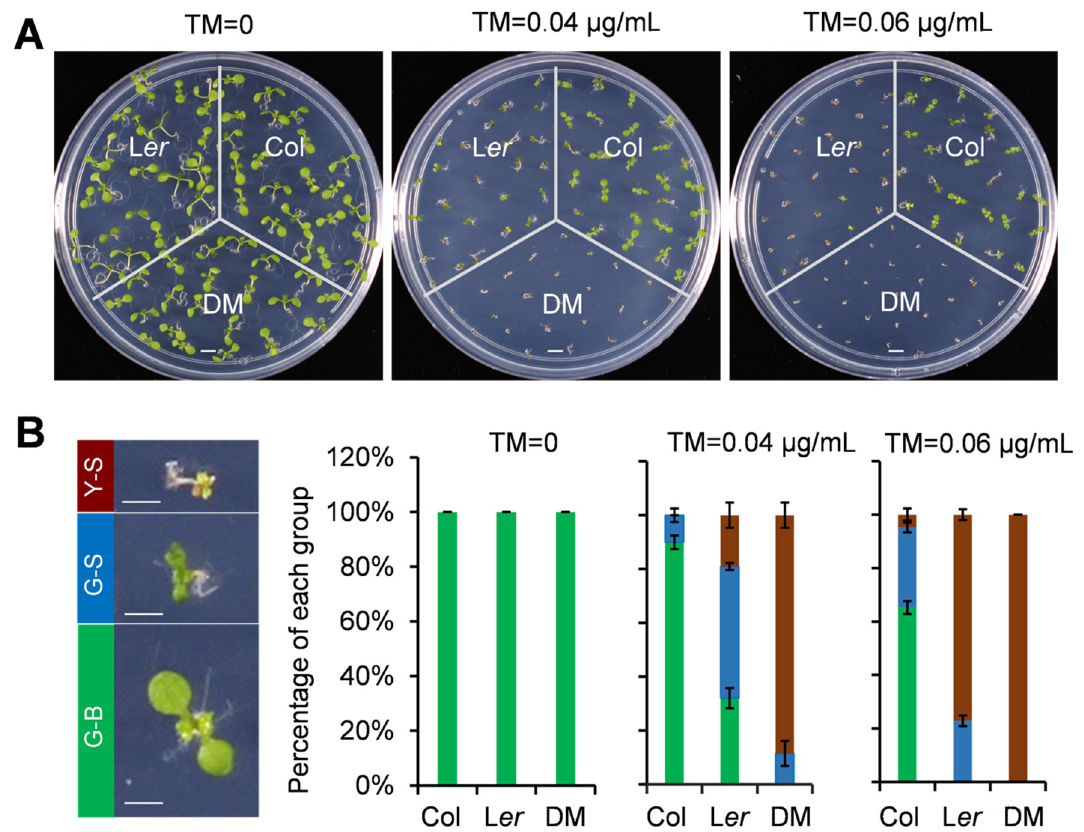
Figure 1. Endoplasmic reticulum (ER) stress sensitivity assays in Columbia (Col), Landsberg erecta (L er ), and double mutant (DM) plants. ( A ) Wild-type Col and L er plants were grown on 1 without or with various concentrations of tunicamycin (TM) for 9 days, and then photographed; ( B ) The percentage of green-big (G–B), green-small (G-S) and yellow-small (Y-S) plants was calculated after photo-taking. Bars depict SE ( n = 3). The di ff erence of each group between L er and Col under ER stress conditions is significant ( p < 0.05). The bzip28 bzip60 double mutant (DM) plants in the Col background was used as a control. Bar = 5